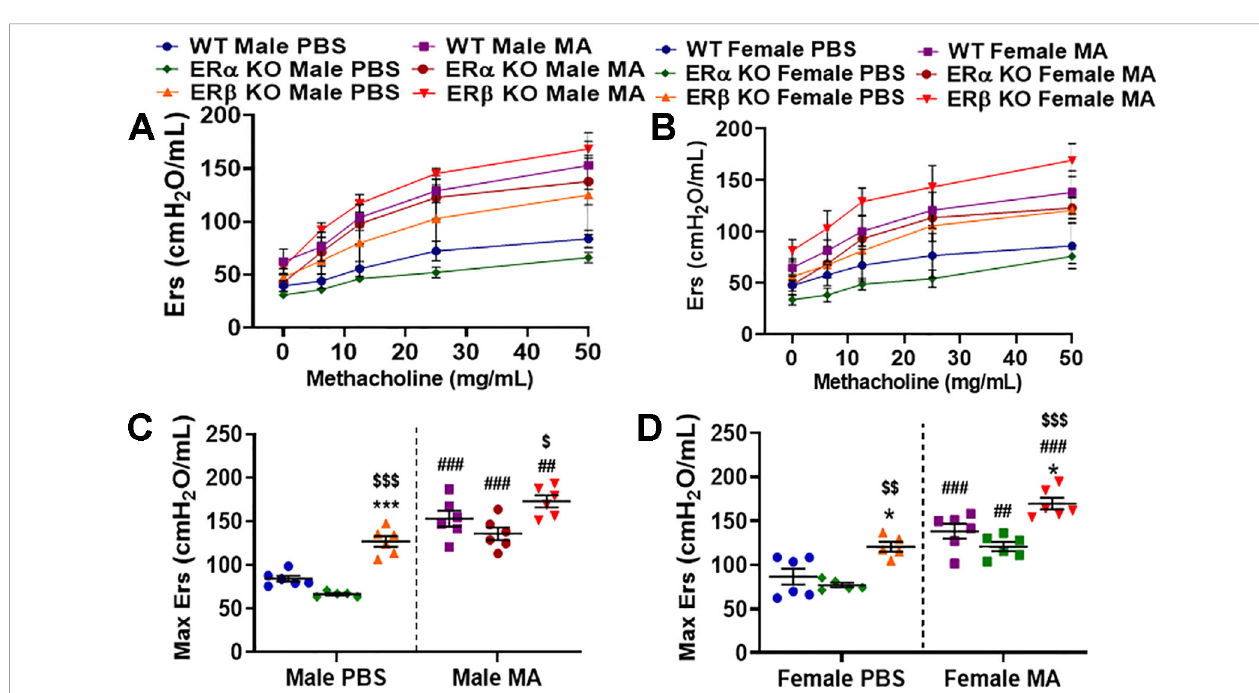
FIGURE 4 | Effect of ER signaling on elastance (Ers) in the lungs of (A) male and (B) female mice (WT vs. ER a KO vs. ER b KO) exposed to PBS and MA. Max Ers was used to compare WT, ER a KO and ER b KO in (C) male and (D) female mice exposed to PBS and MA. Data represented as mean ± SEM of at least 5-6 mice per treatment group; ## p < 0.01, ### p < 0.001 vs. PBS of respective groups (MA effect), *p < 0.05, ***p < 0.001 vs. WT of PBS/MA (ER speci fi c KO effect) and $ p < 0.05, $$ p < 0.01, $$$ p < 0.001 vs. ER a KO of PBS/MA (ER b vs. ER a